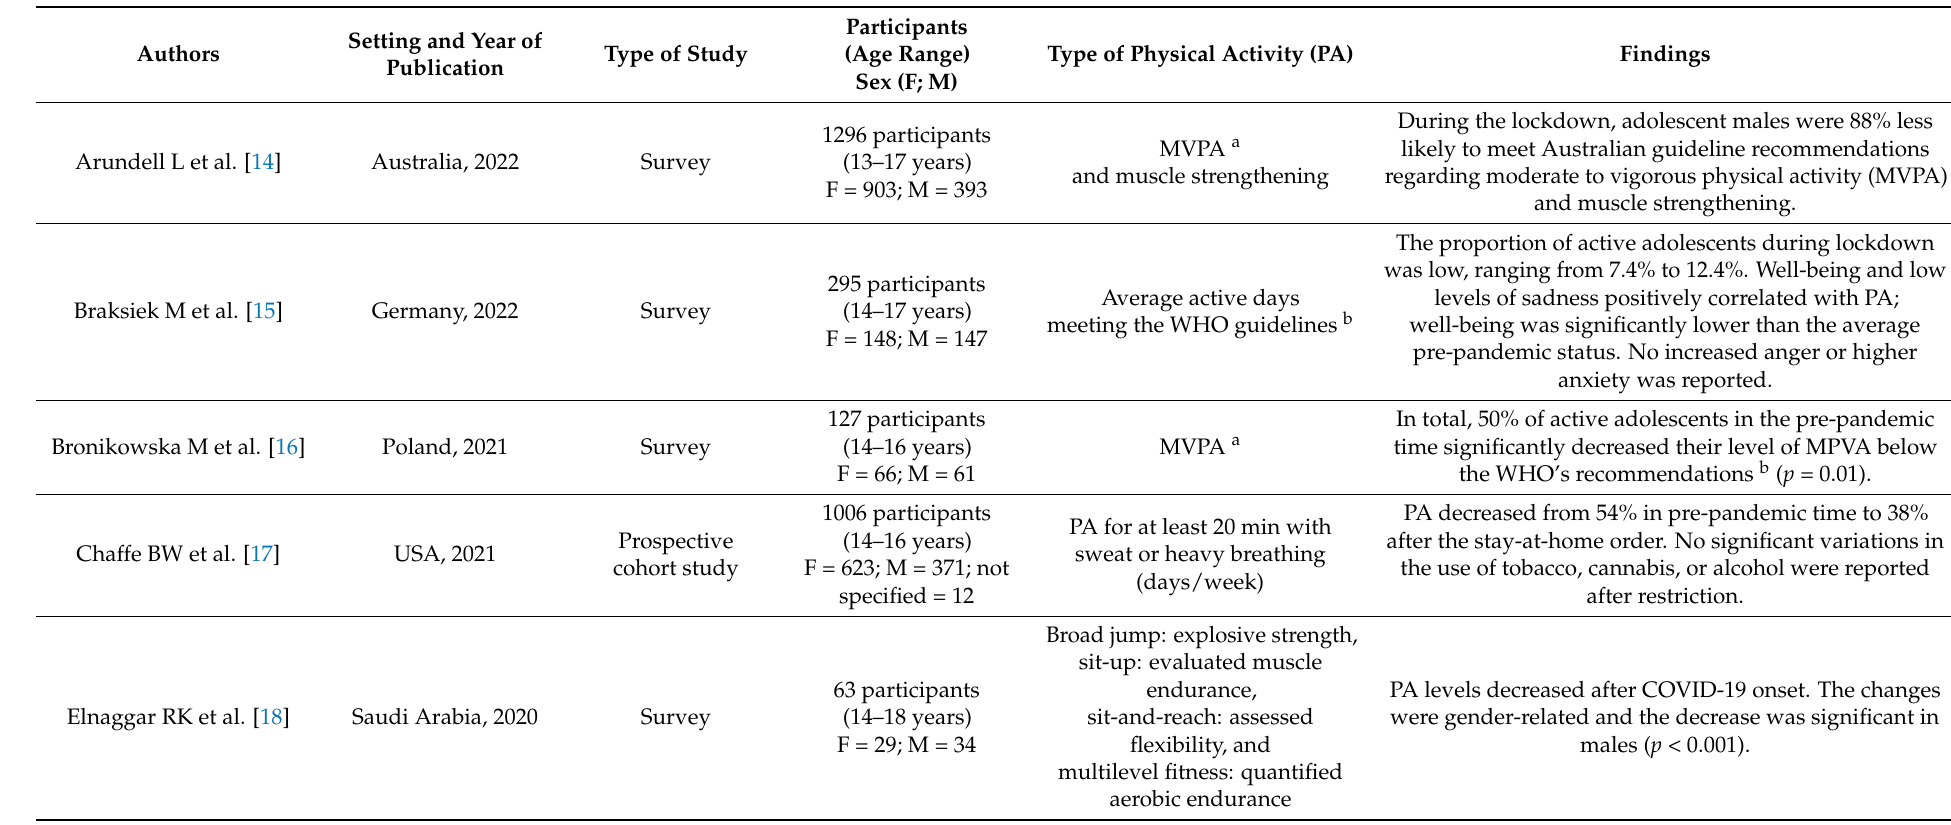
Table 1. Main findings of the literature review. a MVPA: moderate-to-vigorous physical activity. b WHO guidelines: being active for at least 60 min every day in